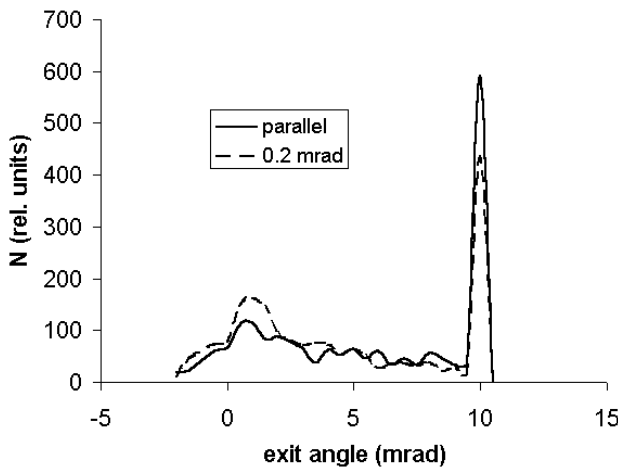
FIG. 1. Angular distribution of 1 GeV protons downstream of the silicon crystal bent 10 mrad. For the parallel incident beam (solid line), and for the beam incident with divergence of 0.2 mrad (dashed